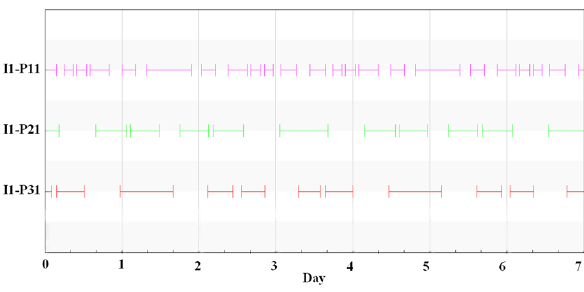
Figure 3: Visible relationship between the IGSO1 satellite and the MEO satellite.